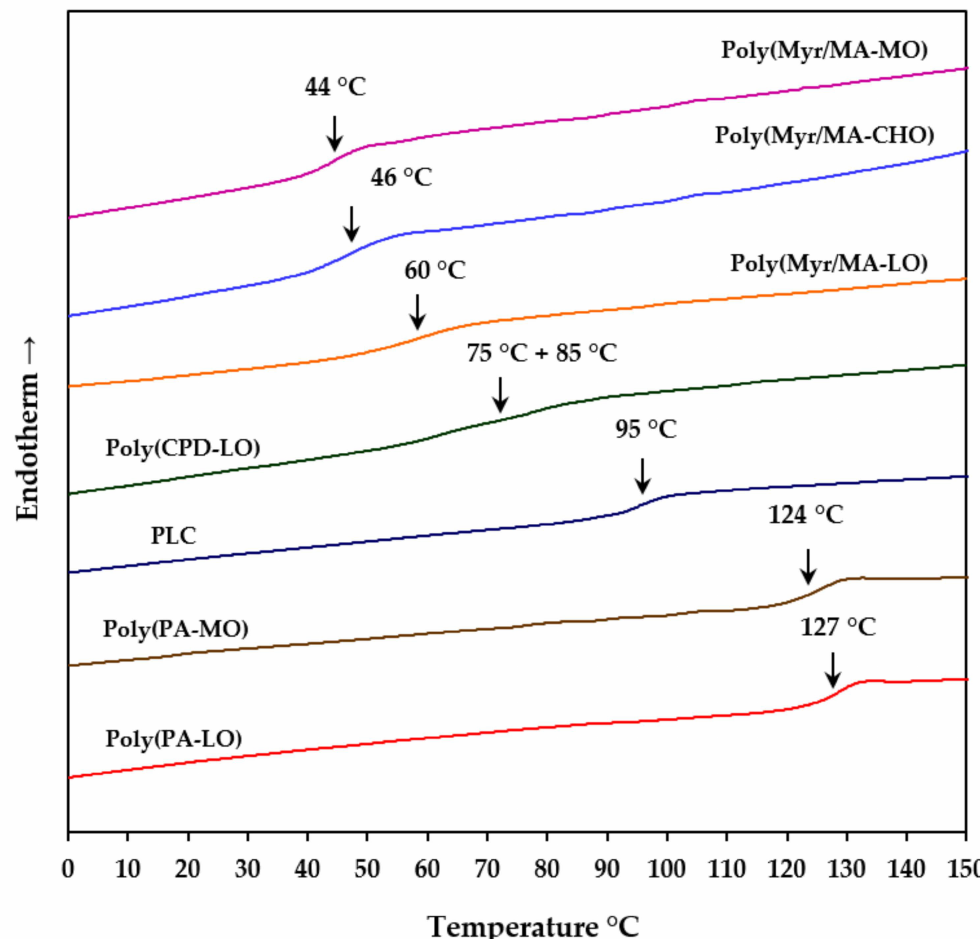
Figure 3. DSC heating runs of the synthesized terpene